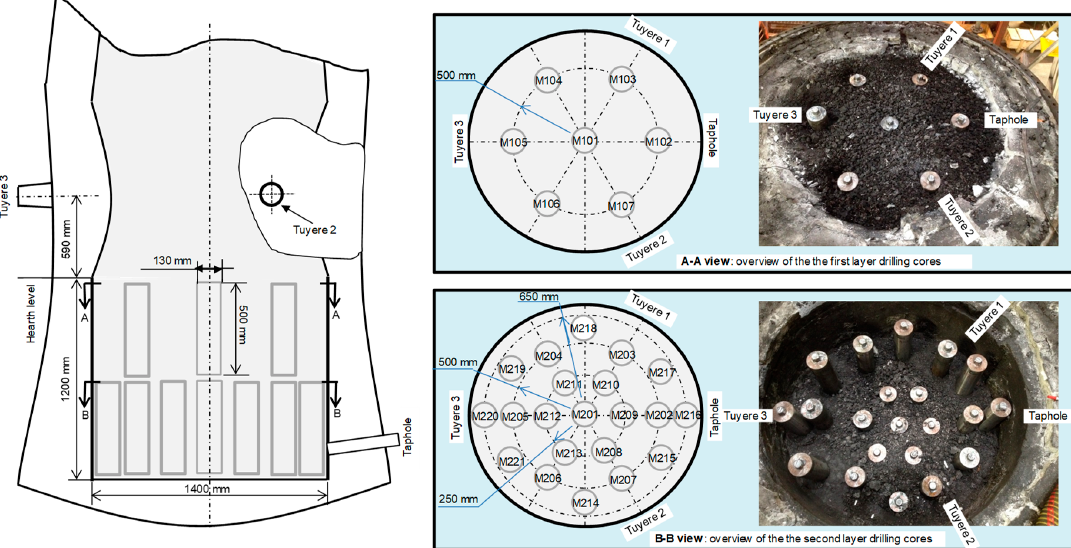
Figure 1. Illustration of the sampling positions (with respect to the 3 tuyeres and taphole) for the core ‐ drilling samples and their reference numbers.